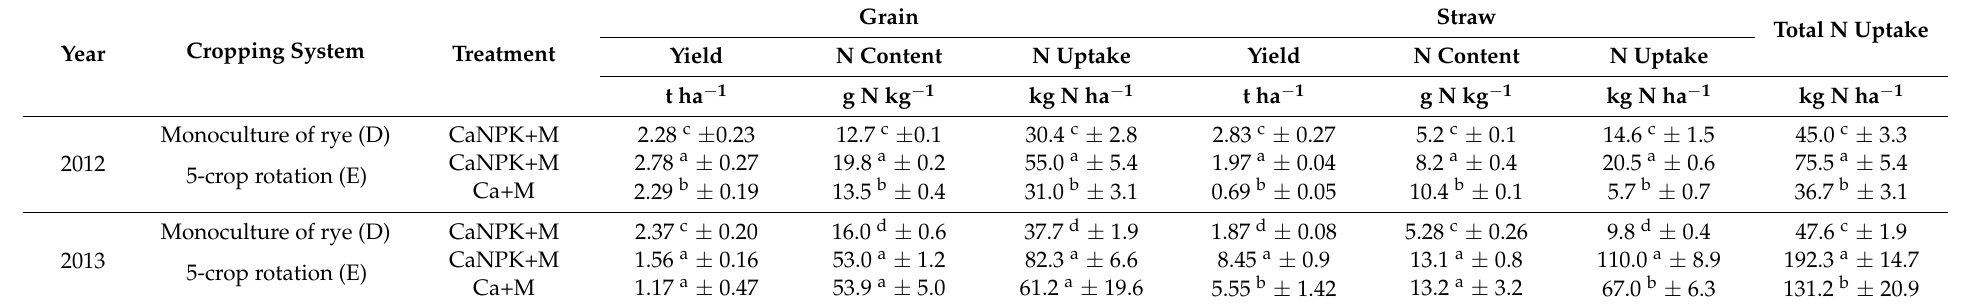
Values followed by the same letters in the column (separated for 2012 and 2013) are not statistically different (Tukey HSD multiple range test, p < 0.05). SD—standard